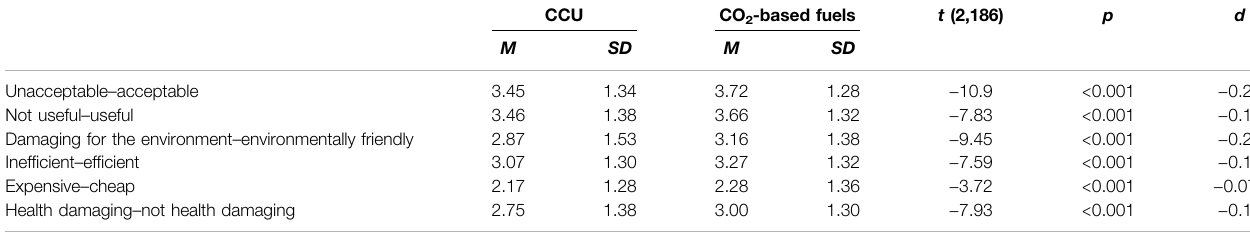
TABLE 2 | Results of paired samples t-test for differences in the affective evaluation of CCU and CO 2 -based fuels.